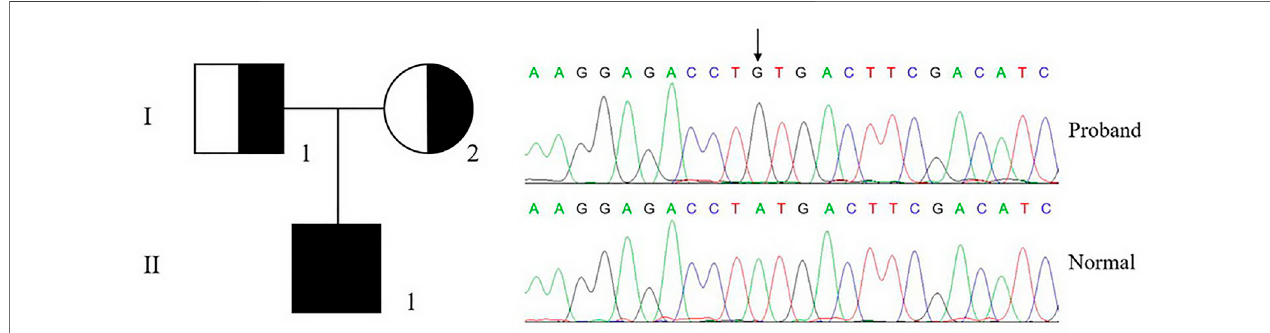
FIGURE2| Geneticanalysisofprobandandpedigree.Thegeneticanalysisshowsthattheproband(II-1)carriesahomozygousc.956a > g,p.Tyr319Cysmutation in F10, which is inherited from his parents.